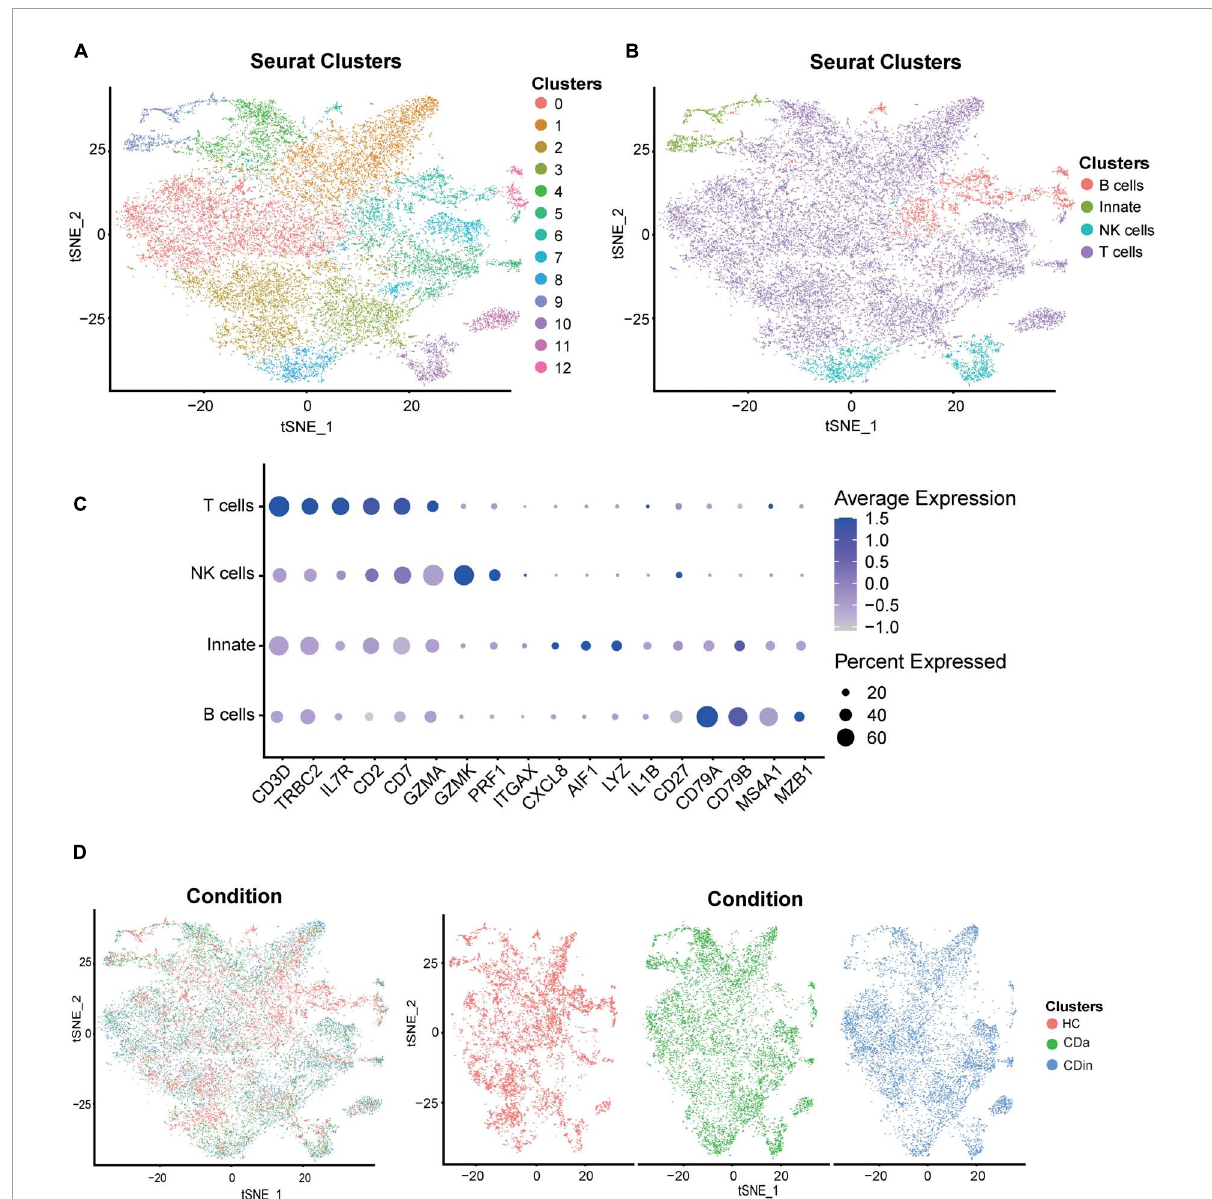
FIGURE7 Recognition of diverse cells among CDa, CDin, and HC using scRNA-seq. (A) Visualized t-SNE plot derived from the clustering of CD and HC data in GSE13480 and GSE152321, colored and numbered depending on the clustering results. (B) The t-SNE plot is colored and labeled based on inferred cell type identity. (C) Dot plot depicting the expression levels of relevant genes in different cell clusters. (D) t-SNE plots show the distribution of tissue cells from different states (CDa, CDin, and